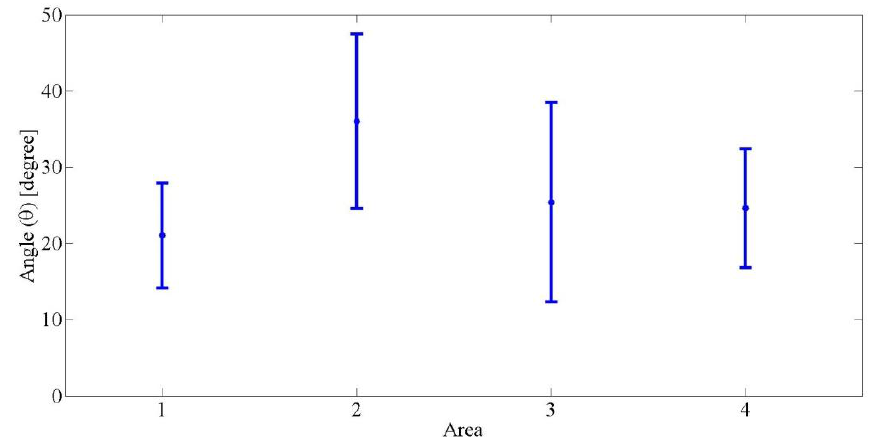
) and vertical (s ) for the three 1 2